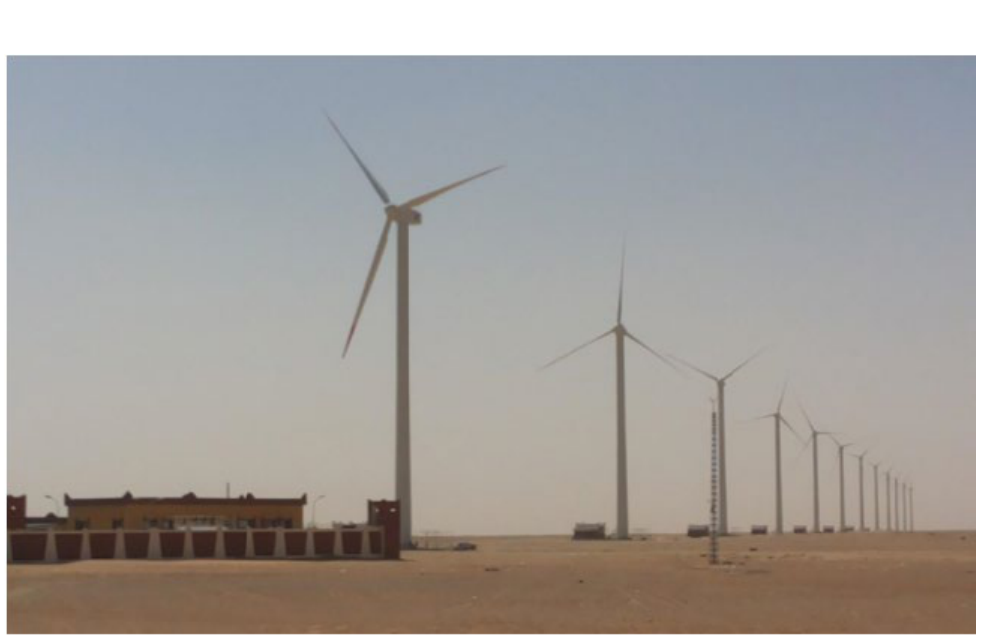
Figure 7. Panoramic photograph of the 10 MW wind turbine farm (Kaberten) The power transformer technical specifications are given in Table. 13.